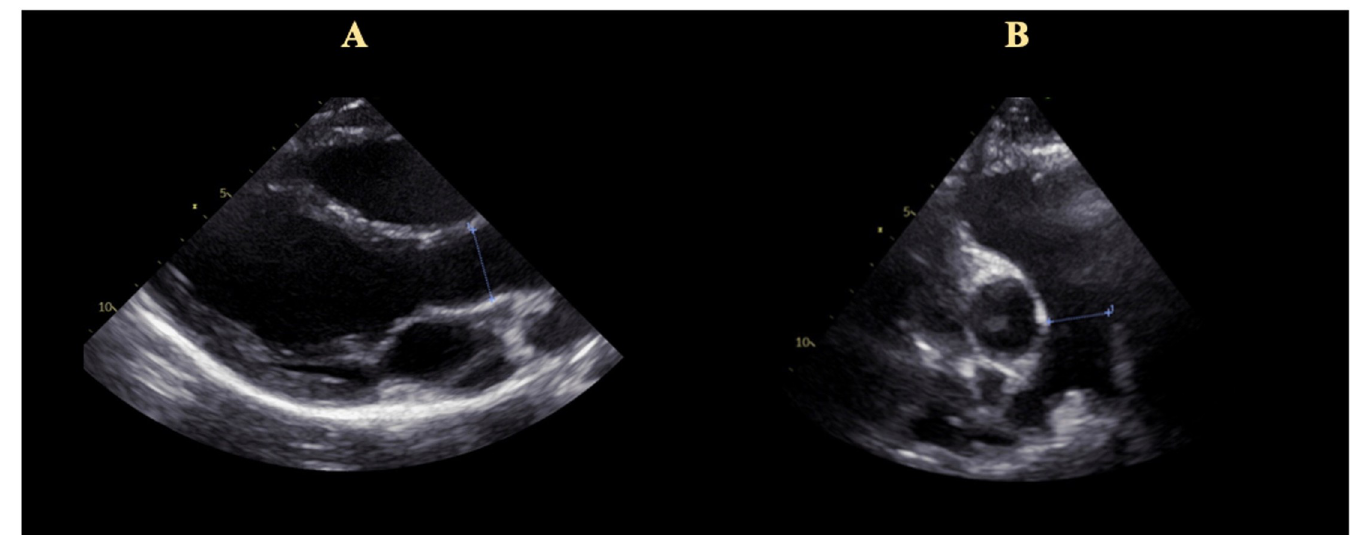
Fig 1. Calculation of the pulmonary artery to ascending aorta ratio (PA:A). Panel A: Parasternal long axis view with measurement of the ascending aorta. Panel B: Parasternal short axis view with visualization of the pulmonary trunk and the bifurcation. Measurement of the main pulmonary artery.